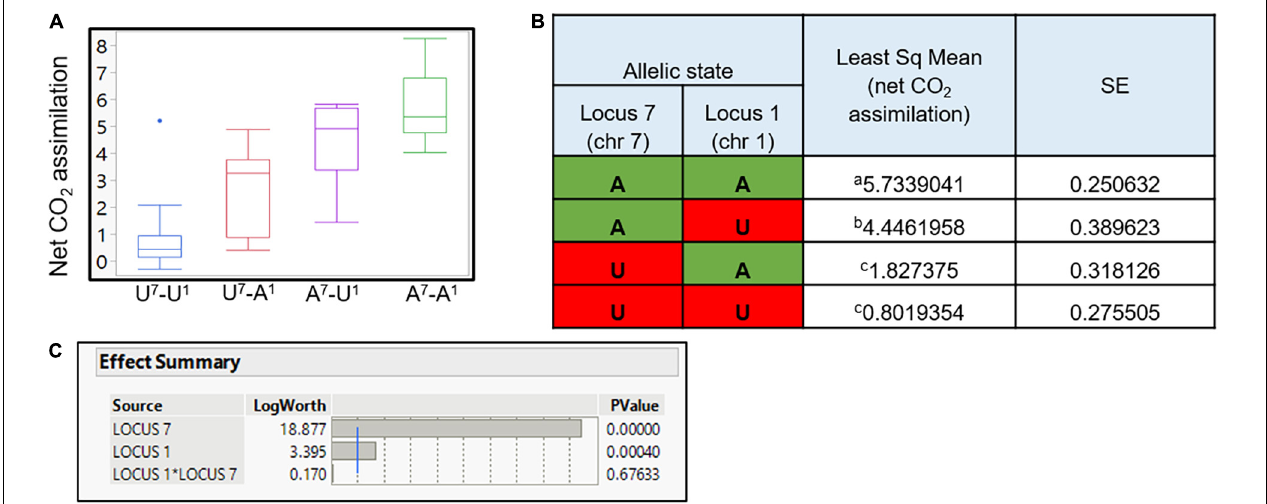
FIGURE 7 | QTLs effect on net CO 2 assimilation and the synergistic effect between QTLs. Least square of means for each allelic combination is presented (A) . Each box plot represents the population individual’s average phenotype grouped for their allelic combination. Y -axis is the level of net CO 2 assimilation. The x -axis represents the allelic combination. On the x -axis, the capital letter A refers to individuals with P. arabica allele combination, U refers to individuals with U.E.F. allele combination in each one of the QTL, and superscript numbers (7 and 1) present the QTL identity. Numerical presentation of the data is presented in (B) . P. arabica allele combination is marked in green, and U.E.F. marker combination is marked in red. Different letters indicate significance ( α = 0.05). Statistical evaluation of each QTL effect, and interaction between the two loci (C) . Presented results were analyzed by the “full factorial test”; blue line is equivalent for P -value of α =